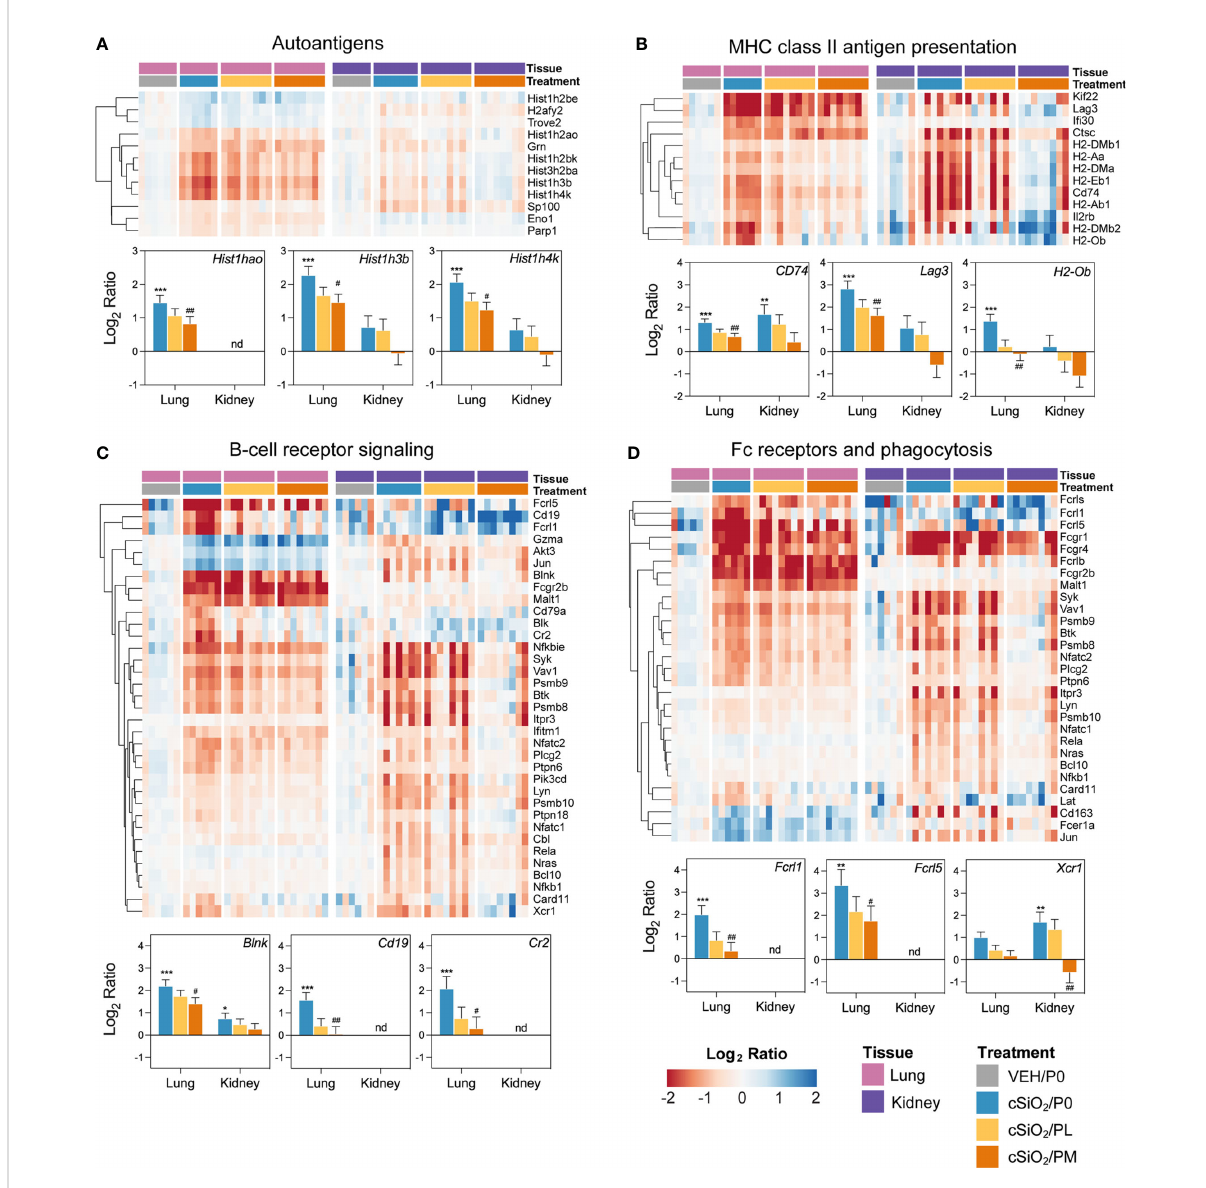
FIGURE 7 Comparison of prednisone-responsive genes associated with (A) autoantigen, (B) MHC class II antigen presentation, (C) B-cell receptor signaling, and (D) Fc receptors and phagocytosis pathways in lung or kidney tissues 14 weeks post instillation with cSiO 2 . Gene expression data were obtained using the NanoString Autoimmune Pro fi ling gene panel and are shown as log2 ratios for cSiO 2 /P0, cSiO 2 /PL, and cSiO 2 /PM treatment groups with respect to the tissue-matched VEH/P0 control group (log2 ratio = 0). For each pathway, heatmaps with unsupervised hierarchical clustering (Euclidian distance method) by gene show log2 expression values for all genes identi fi ed as differentially expressed in response to either cSiO 2 exposure or moderate-dose prednisone (FDR q<0.05, 1.5-fold change) in either of the selected tissues. The mean log2 ratio values + SEM for selected genes of interest are also shown for each pathway. For for cSiO 2 /P0 as compared to VEH/P0, *, FDR-corrected q<0.05; **, q<0.01; and ***, q<0.001. For cSiO 2 /PL or cSiO 2 /PM vs cSiO 2 /P0, # , FDR-corrected q<0.05; and ## , q<0.01. nd stands for not detected. See Supplementary File 1 for test speci fi cations and FDR-corrected q-values for all genes in the panel for all comparisons. cSiO 2 , crystalline silica; P0, zero prednisone; PL, low-dose prednisone; PM, moderate-dose prednisone; VEH, vehicle